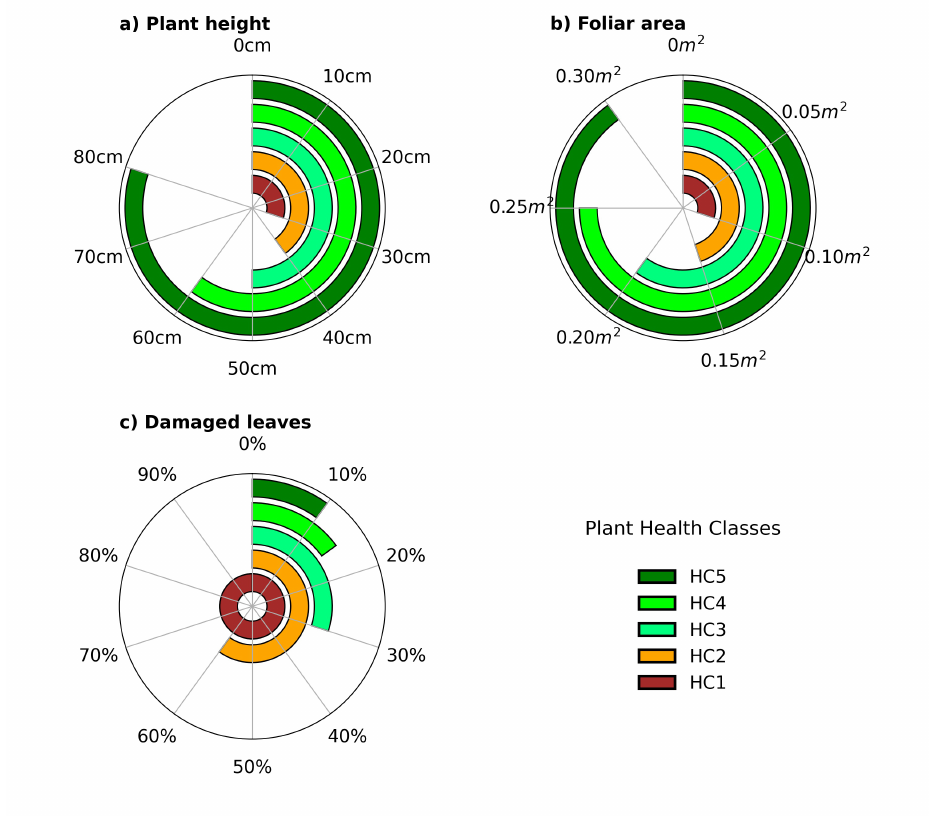
Figure 2. Plant health classes. Phenotype traits for each plant